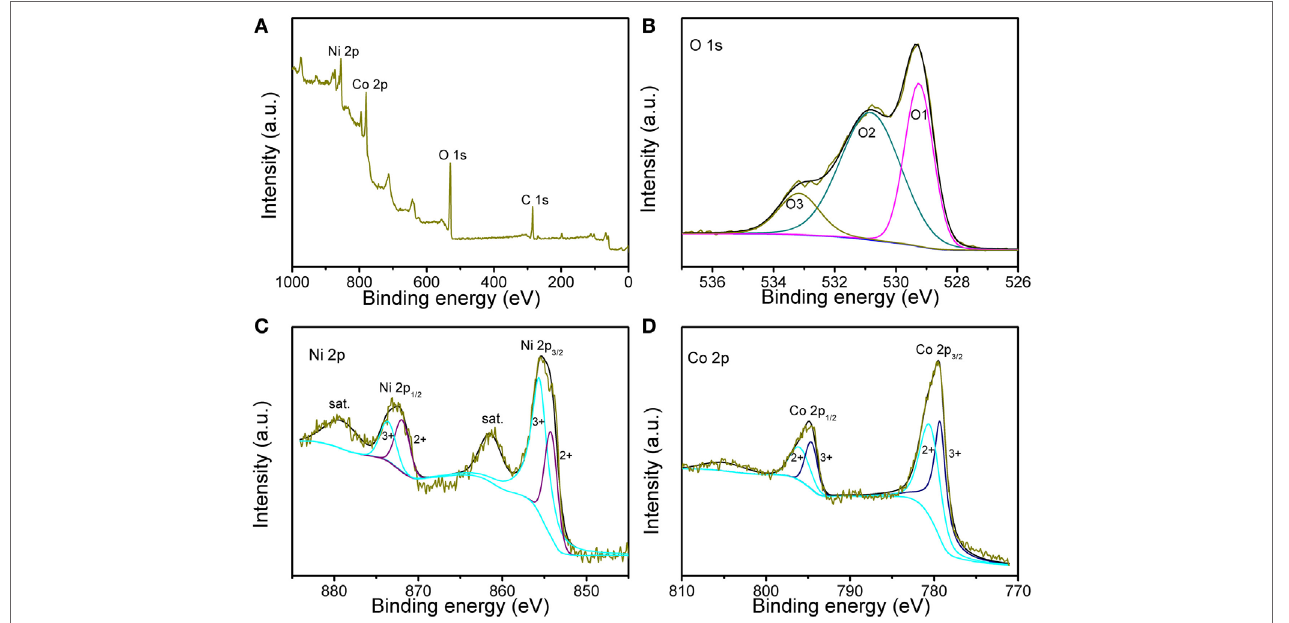
FigUre 3 | X-ray photoelectron spectroscopy (XPS) spectra of (a) survey spectrum, (B) O 1 s, (c) Ni 2p, and (D) Co 2p regions for the